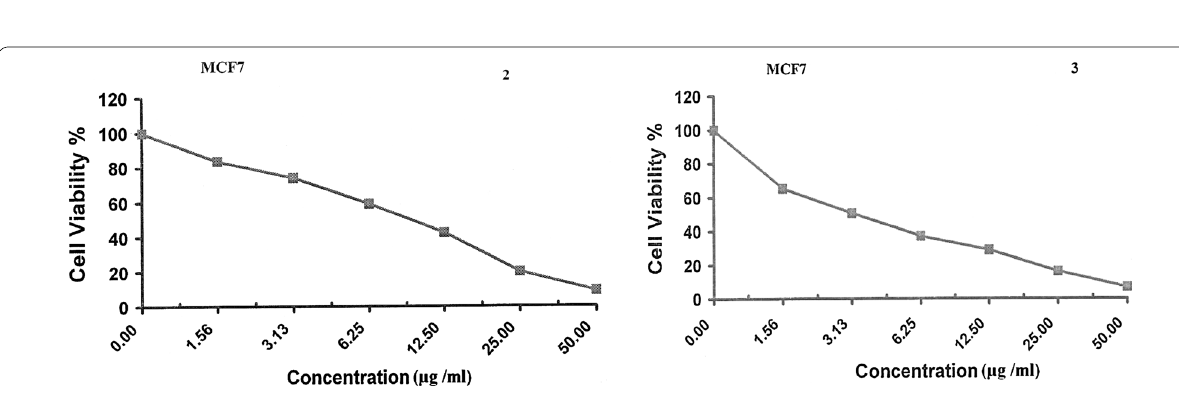
kinase 2 enzyme (Fig. 5c) revealed arene-hydrogen inter- action with bond length of 4.23 Å and binding energy of 0.6 (kcal/mol) with Ile10. There was a hydrogen accep- − tor interaction between Gln131 and one of the sulphur atom of the compound with bond length of 4.05 Å and binding energy of 1.1 kcal/mol. −